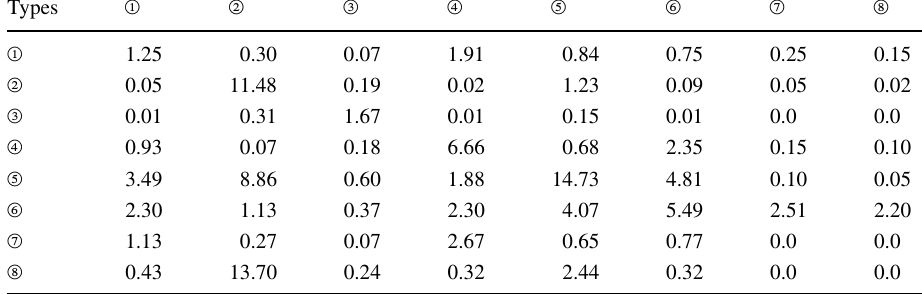
wetland structure types in Dongping Lake from 2015to 2020 (km 2 )